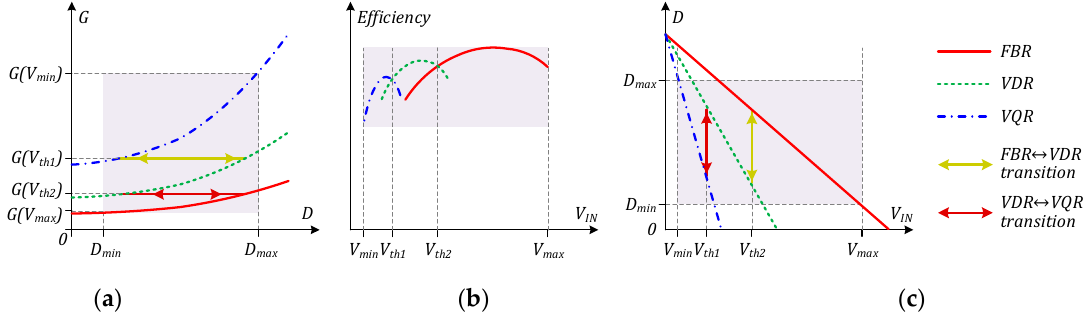
Figure 6. Idealized sketch of the operating principle of the high step-up DC-DC converter with front-end BHBI: ( a ) dc voltage gain curves and transitions between them, ( b ) predicted efficiency curves shapes and transitions between them, and ( c ) the linear dependencies of the duty cycle on the input voltage.